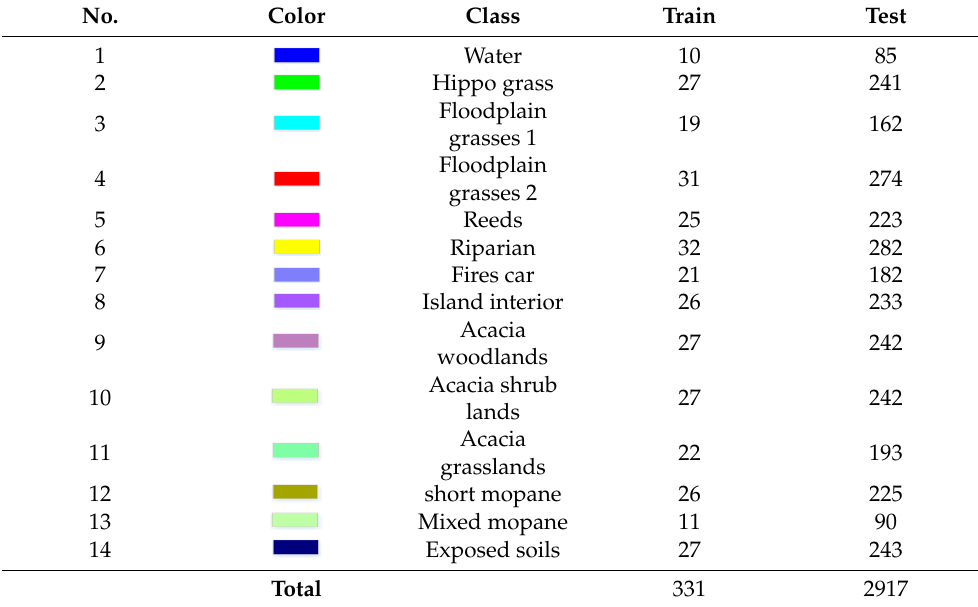
Table 2. The information of sample numbers of the IP dataset.